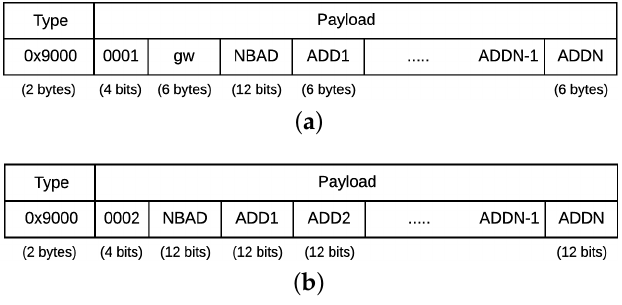
Figure 8. ( a ) Sub-structure of an auto-configuration control message within a peripheral ring; ( b ) Sub-structure of an auto-configuration control message within a backbone